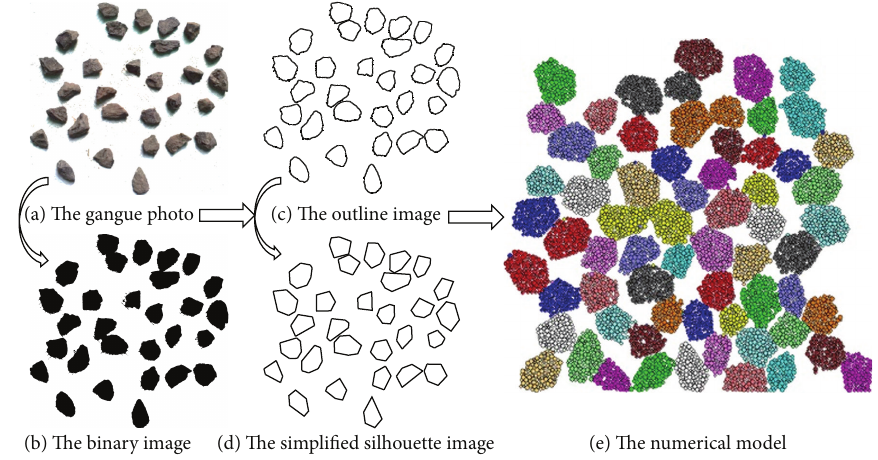
Figure 2: The modelling processes of spoils.